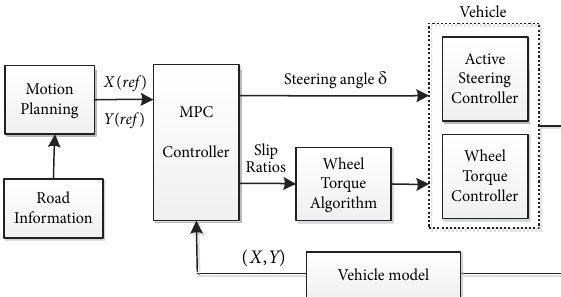
Fig. 7. The control scheme for autonomous electric vehicle